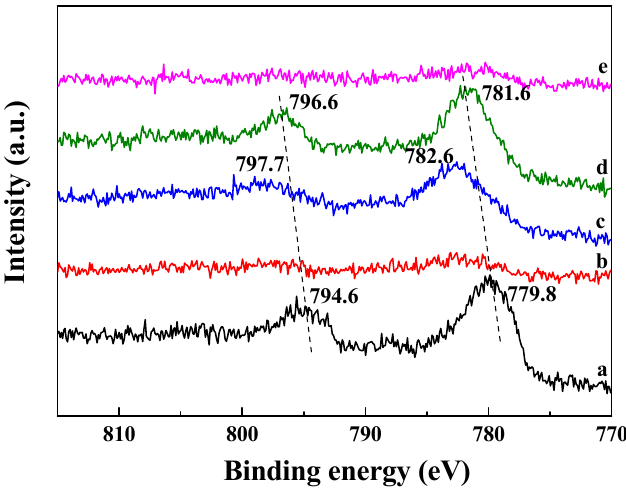
Figure 4. XPS spectra in the Co 2p region of the calcined Co / SiO 2 (a), Co-3gly / SiO 2 (b), Co(1gly) / SiO 2 (c), Co(3gly) / SiO 2 (d), and Co(5gly) / SiO 2 (e).